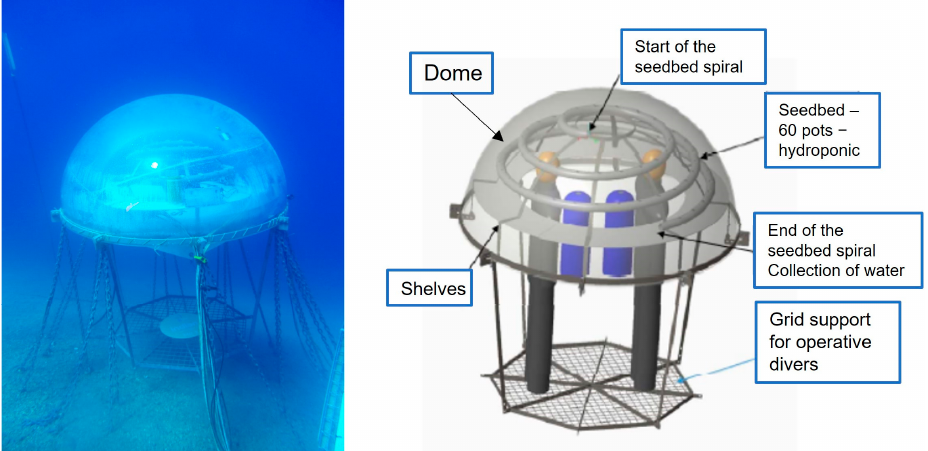
Figure 1. The underwater greenhouse (biosphere): in-situ photograph and description of its main elements.